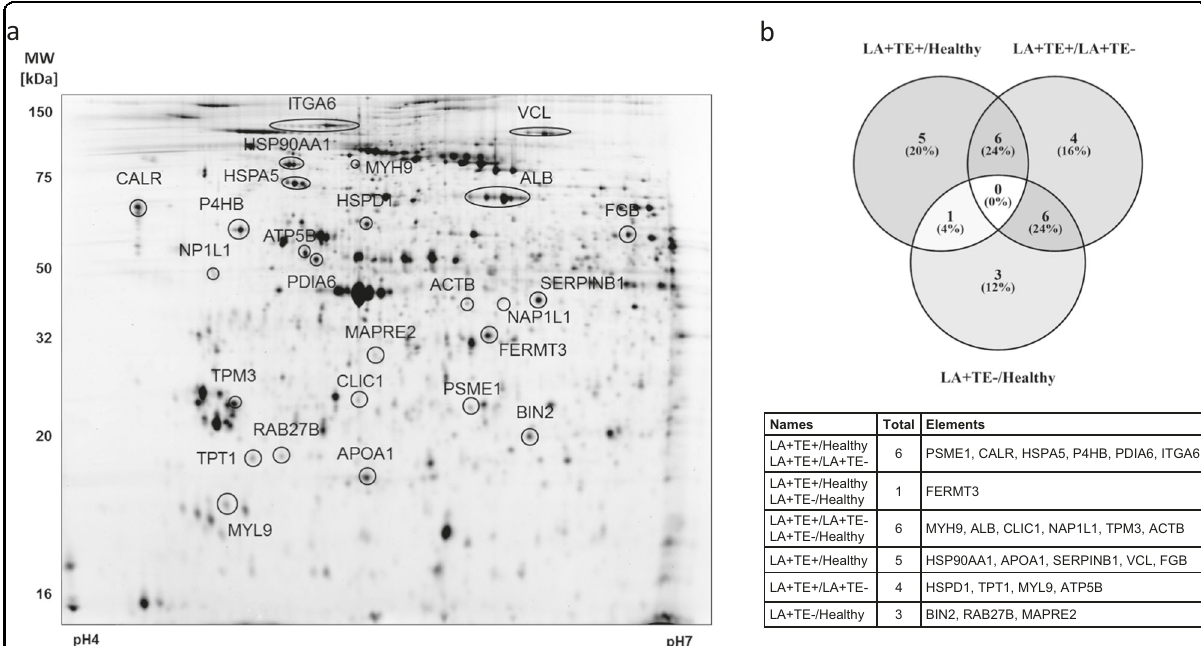
Fig. 1 Altered platelet proteins analyzed by 2D-DIGE. a Representative 2D-DIGE gel with altered platelet proteins between LA + TE + patients compared to control groups. Detailed descriptions of the highlighted proteins are listed in Table 1. b Venn diagram 58 illustrating the overlap between the altered protein spots between LA + TE + /Healthy, LA + TE + /LA + TE − and LA + TE − /Healthy. MW molecular weight, kDa kilodalton, 2D-DIGE two-dimensional differential in-gel electrophoresis, LA lupus anticoagulant, TE